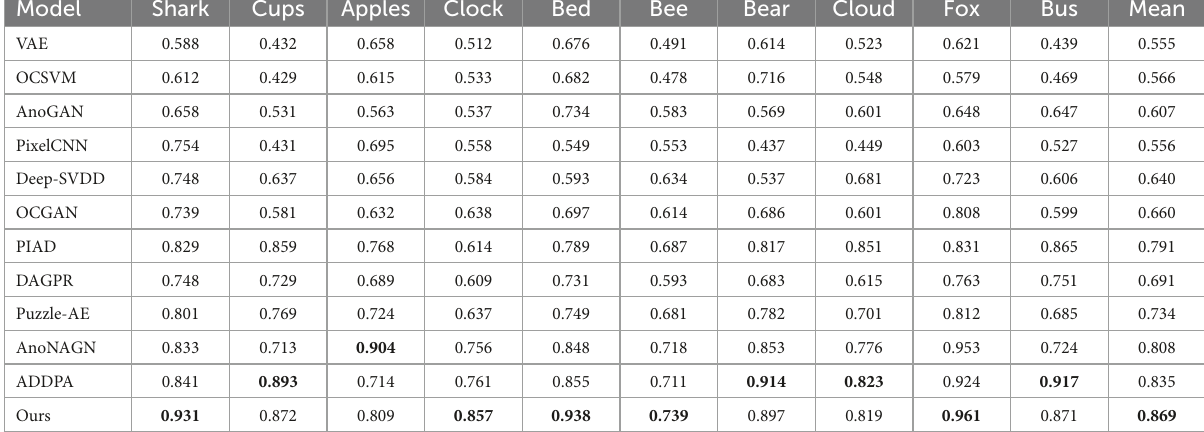
TABLE 4 Anomaly detection results for CIFAR-100 dataset.